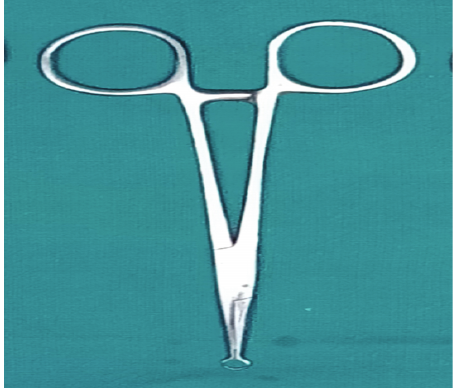
Figure 2 : Extracutaneous vas holding